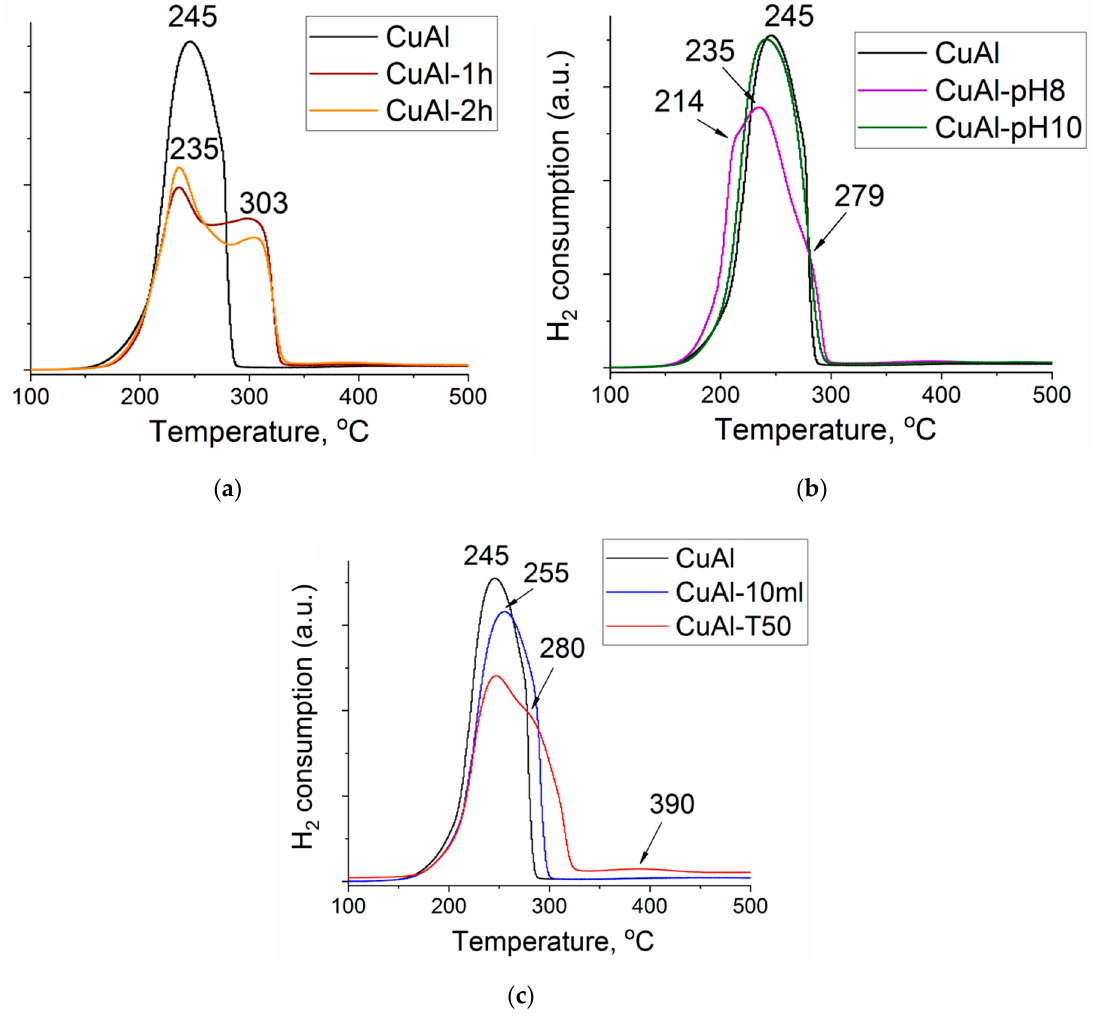
Figure 4. H 2 -TPR curves of the samples ( a ) aged for different time, ( b ) prepared at different pH, ( c ) synthesized at different precipitation rates and temperature. Table 3. H 2 -TPR, XPS and coherent scattering region of the reduced samples.